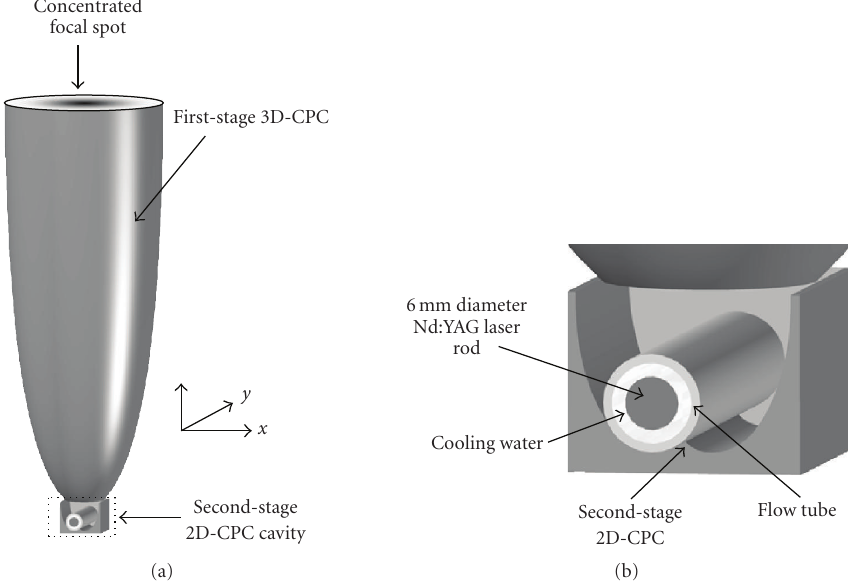
Figure 1: (a) Double-stage 3D-compound parabolic concentrator-2D-compound parabolic concentrator (3D-CPC/2D-CPC) pumping cavity. (b) Enlarged view of the 2D-CPC cavity with the laser rod of 6 mm diameter and 50mm length.